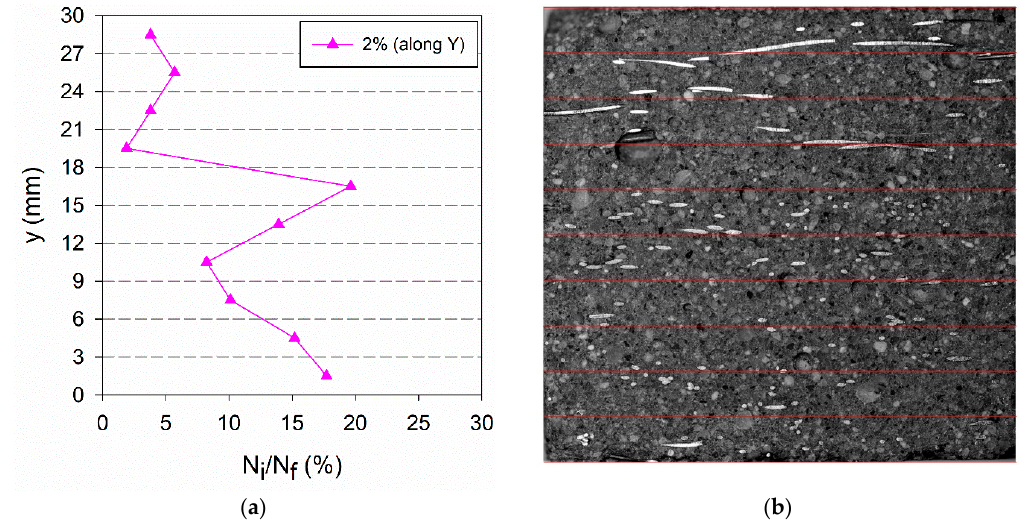
Figure 20. ( a ) Fibre distribution along the plate thickness (Y-direction) for HO_i specimens; ( b ) image of HO_2% along Y-direction.